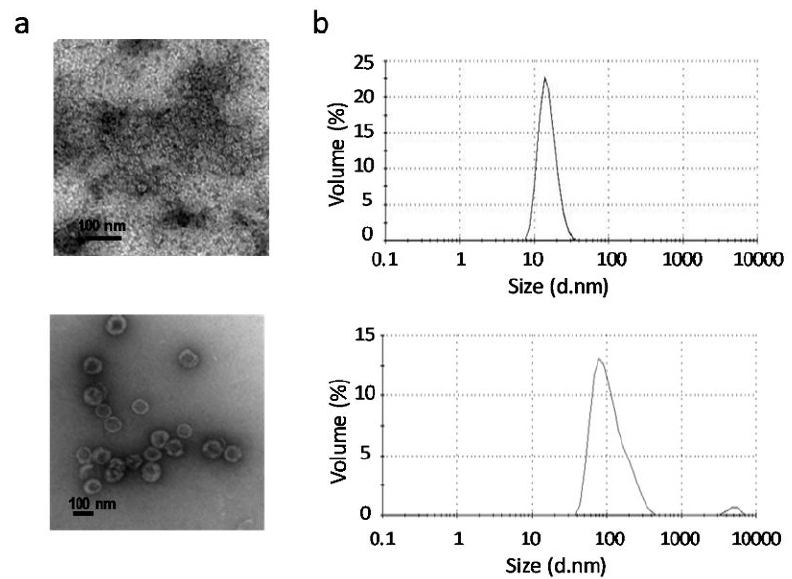
Figure 1. Characterization of the vaccine antigens. ( a ) Electron micrographs of norovirus (NoV) P particles (left panel) and rotavirus (RV) VP6 nanospheres (right panel). Black bar indicates 100 nm. ( b ) Dynamic light scattering (DLS) analysis of the vaccine antigens. Shown are size distributions in nanometers (nm) by volume percent of NoV P particles (left panel) and RV VP6 nanospheres (right panel). The results are presented as the average of 3–5 measurements (each measurement containing 10–20 × 10 s datasets at 25 ◦